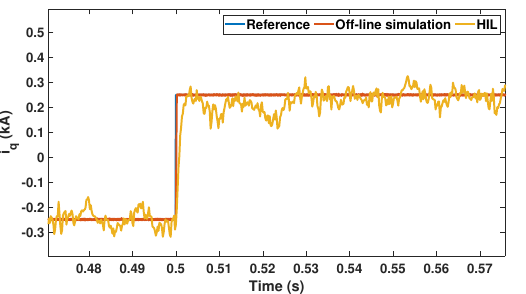
Figure 17. Experimental results of i q using the proposed method subjected to reactive current change.